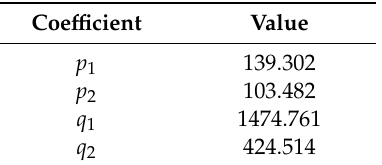
Table 5. Numerical values of the coe ffi cients in Equation